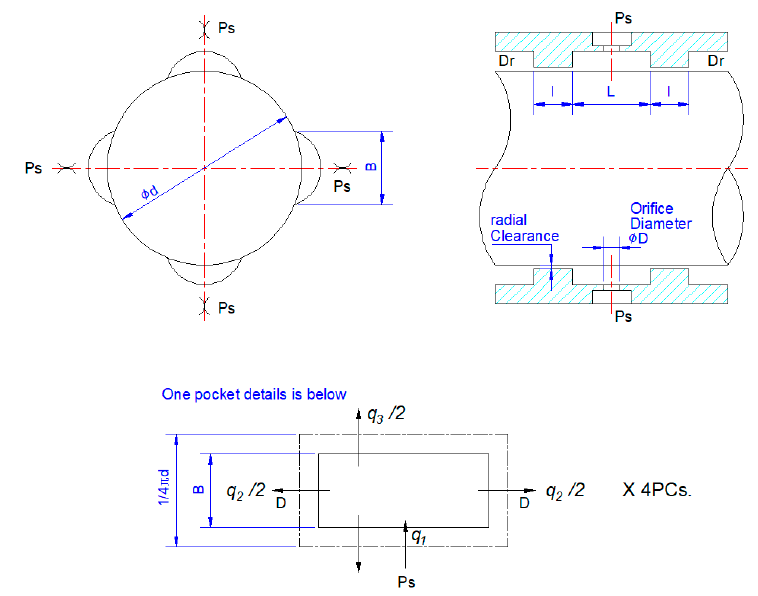
Figure 5. Flow characteristics of hydrostatic bearing.